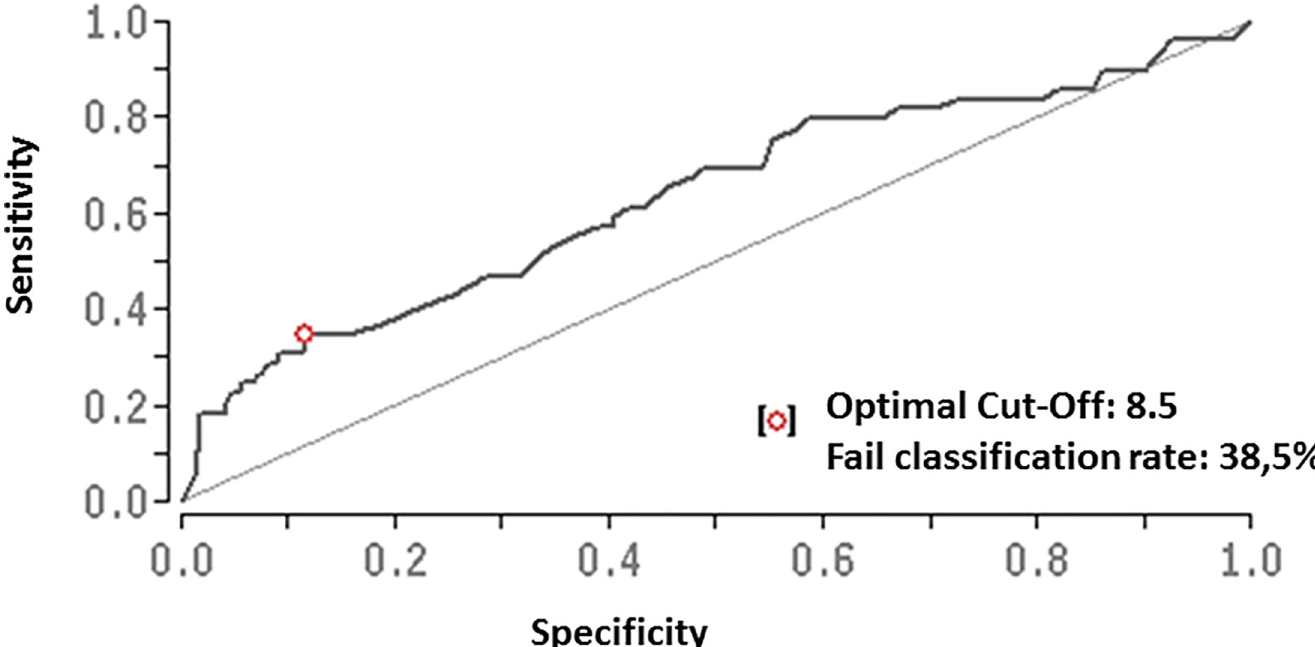
Fig 1. Area under the receiver operating characteristic curve (AUROC) of baseline vitamin D serum levels predicting the risk of hepatic decompensation during follow-up. A 25(OH)D 3 serum concentration of 8.5 ng/mL was identified as the optimal cutoff.